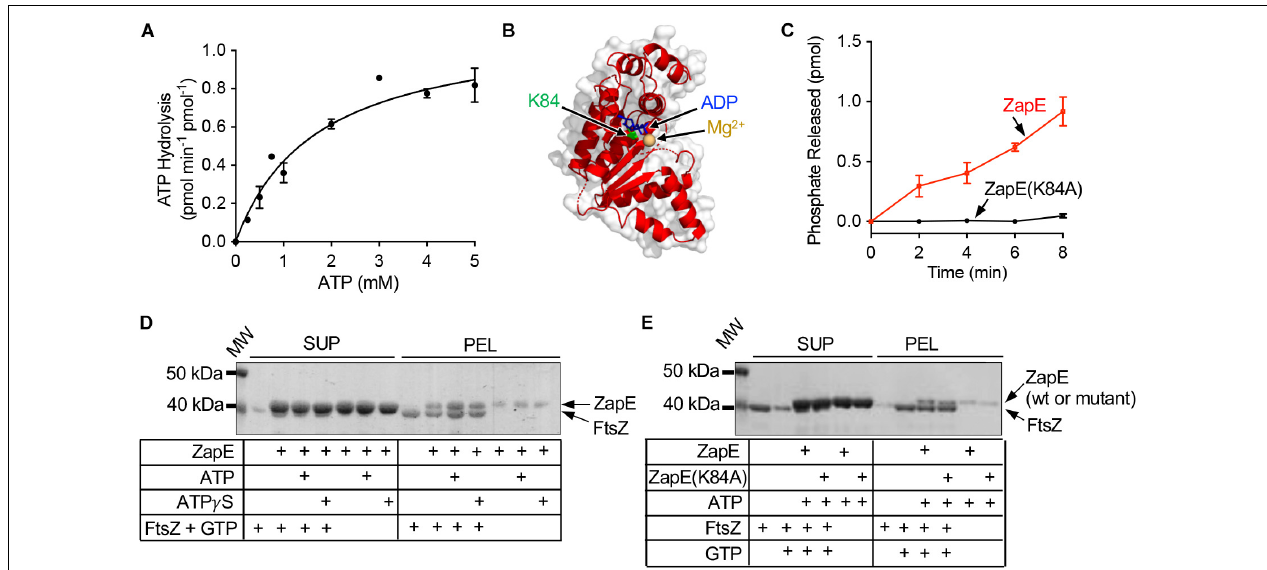
FIGURE 1 | ZapE hydrolyzes ATP and co-pellets with FtsZ polymers in vitro . (A) ZapE (12 µ M) hydrolysis rates were measured by monitoring the release of phosphate with increasing ATP concentrations (0 to 5 mM) as described in Materials and methods section. Data shown are the average of at least three replicates represented as mean ± SEM. (B) Structural model of E. coli ZapE residues (51–275) modeled onto DnaA (pdb 2Z4R) (Ozaki et al., 2008) with nucleotide shown in blue (ADP). Lys 84 is shown as green Corey–Pauling–Koltun model. (C) Hydrolysis of ATP (4 mM) by ZapE (6 µ M) and ZapE(K84A) (6 µ M) was monitored with time (0, 2.0, 4.0, 6.0, and 8.0 min) and phosphate released (pmol) was reported. Data shown are the average of at least three replicates represented as mean ± SEM. (D) FtsZ (6 µ M) polymers were assembled with GTP (2 mM) in the absence and presence of ZapE (8 µ M) alone and with ATP or ATP γ S (4 mM). FtsZ polymers were collected by ultracentrifugation, as described in Materials and methods section, and contents of supernatants and pellets were analyzed by SDS-PAGE to detect ZapE. Data shown are representative of at least three replicates. (E) FtsZ (6 µ M) was incubated without GTP, where indicated, or assembled into polymers with GTP (2 mM) in the absence and presence of ZapE (8 µ M) or ZapE(K84A) (6 µ M) with ATP (4 mM). FtsZ polymers were collected by ultracentrifugation, as described in Materials and methods section, and contents of supernatants and pellets were analyzed by SDS-PAGE to detect ZapE. Data shown are representative of at least three